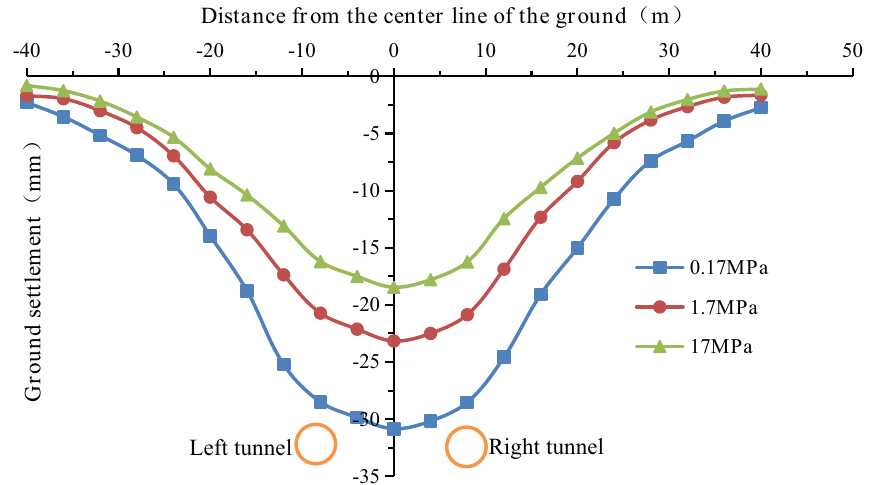
Figure 31. Surface settlement during double-line excavation for different deformation modulus values of the grouting layer.